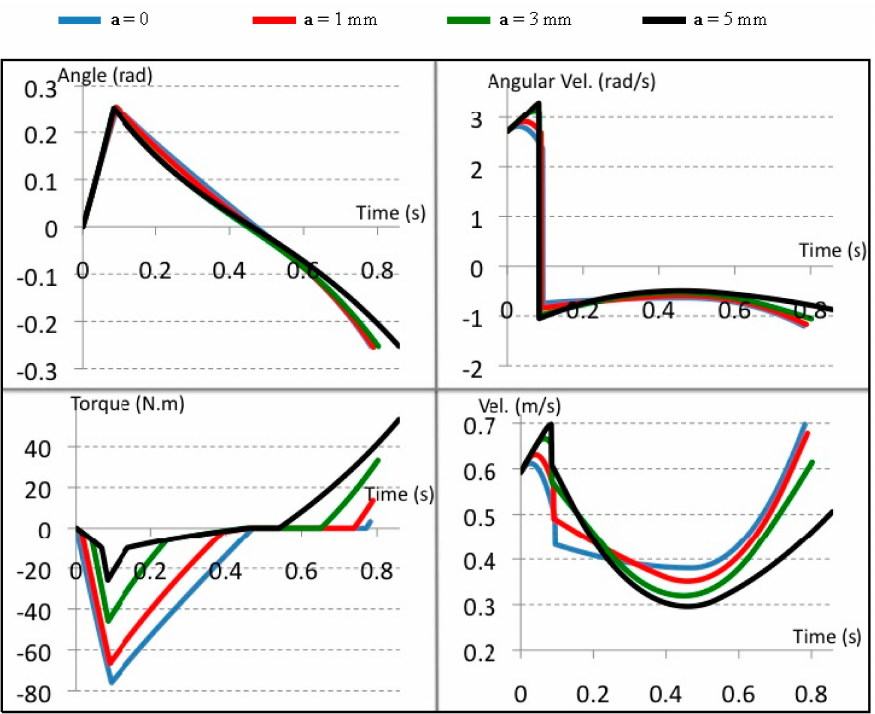
Figure 25. Simulation data for one-step walking in passive mode. The data is for 4 experimental tests with different offset positions. Low stiffness spring constant = 80 N/mm. High stiffness spring constant = 400 N/mm. ( a ) ankle pitch joint angle; ( b ) ankle pitch joint angular velocity; ( c ) ankle pitch joint torque; ( d ) CoM forward